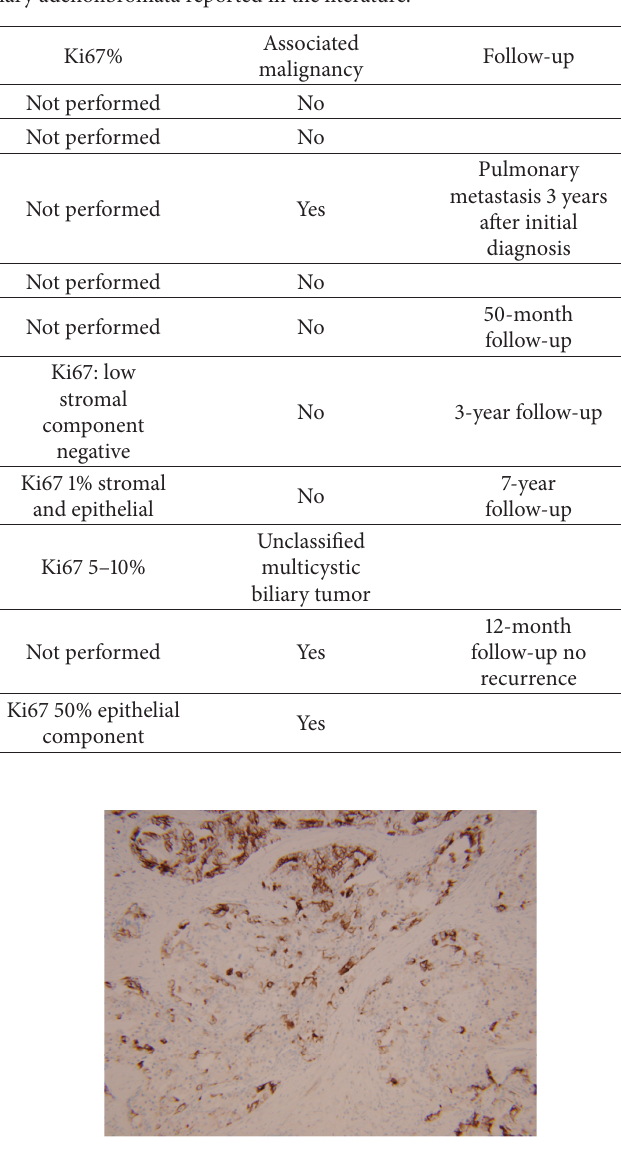
Figure 4: Conventional biliary adenofibroma, CK7, 10x. Figure 5: Invasive carcinoma, CK7,